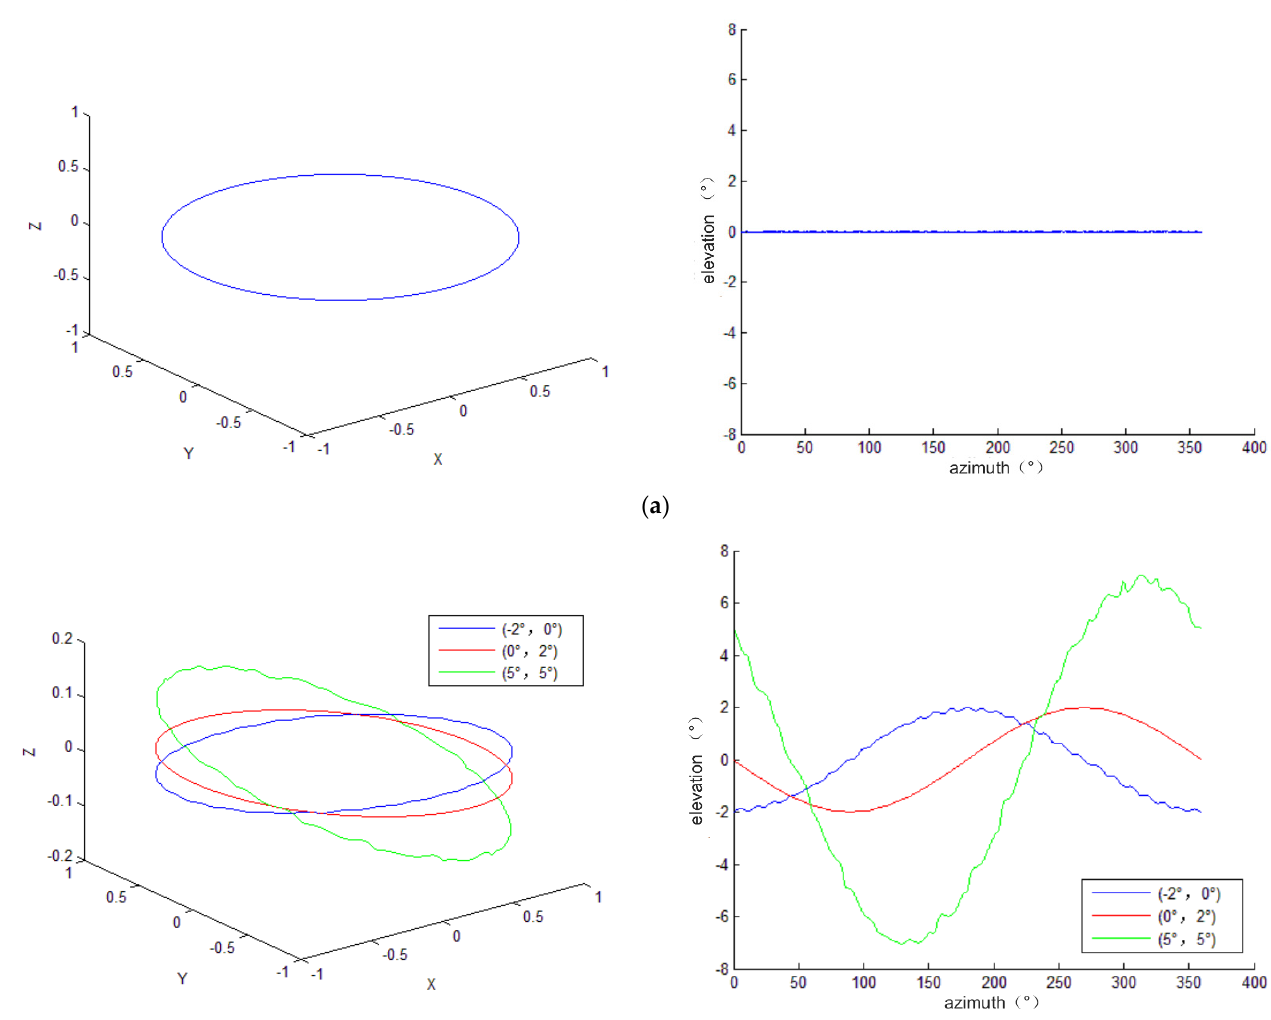
Figure 4. Comparison of LOS pointing curve for two cases under three-dimensional rectangular coordinates and two-dimensional angular coordinates. ( a ) The LOS Pointing curve without installation perpendicularity error (both α and β are 0 ◦ ). ( b ) The LOS pointing curve with installation perpendicularity error ( α , β ) are ( − 2 ◦ , 0 ◦ ), (0 ◦ , 2 ◦ ), (5 ◦ , 5 ◦ ).